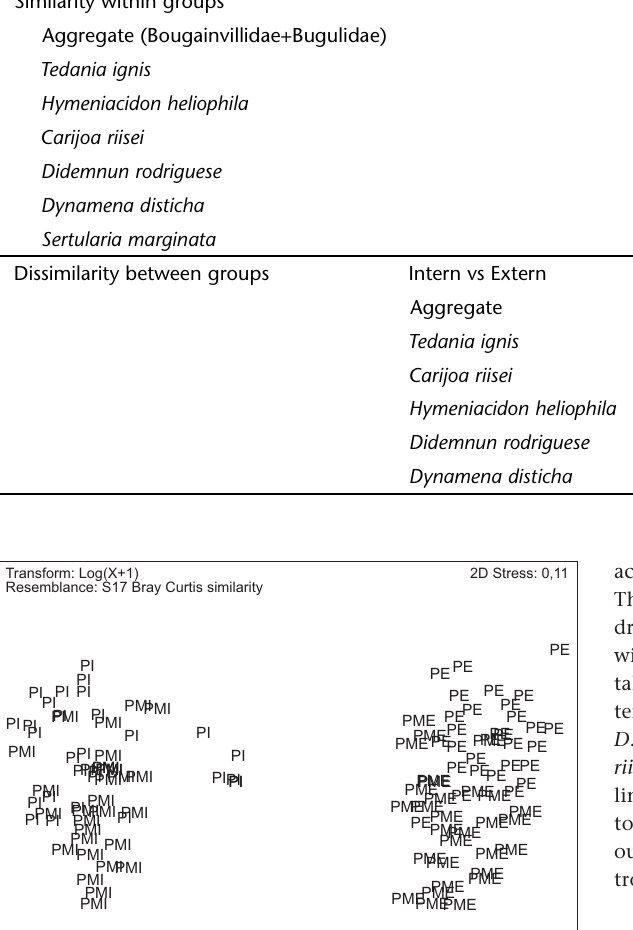
Table IV. SIMPER with the percentage contribution of each taxon to the similarity within and between groups from MDS analysis: PI (Inner Station), PMI (Inner Midpoint), PME (External Midpoint) and PE (External Station). Similarity within and between groups Similarity within